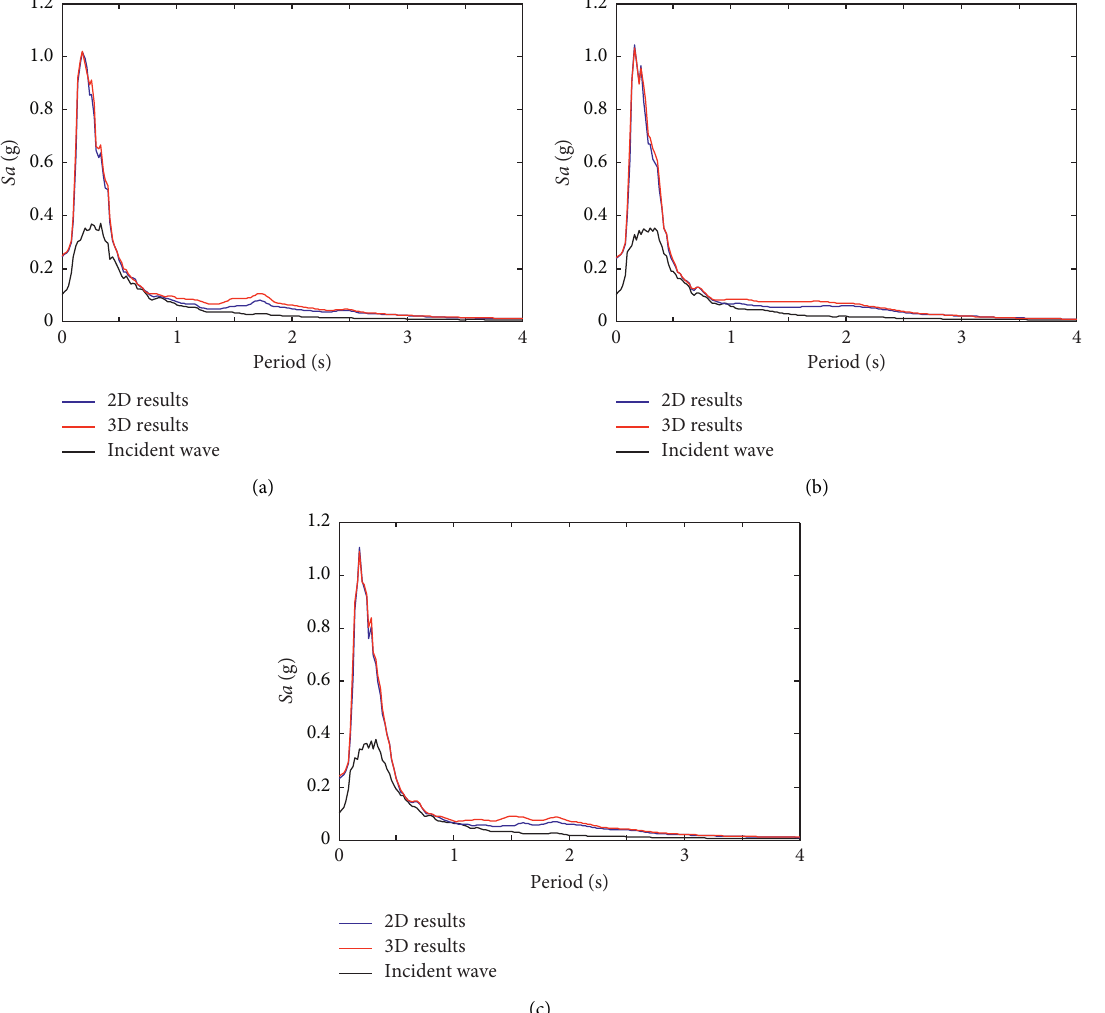
Figure 11: Average response spectra on the reef flat under incidences of (a) seismic wave A; (b) seismic wave B; (c) seismic wave